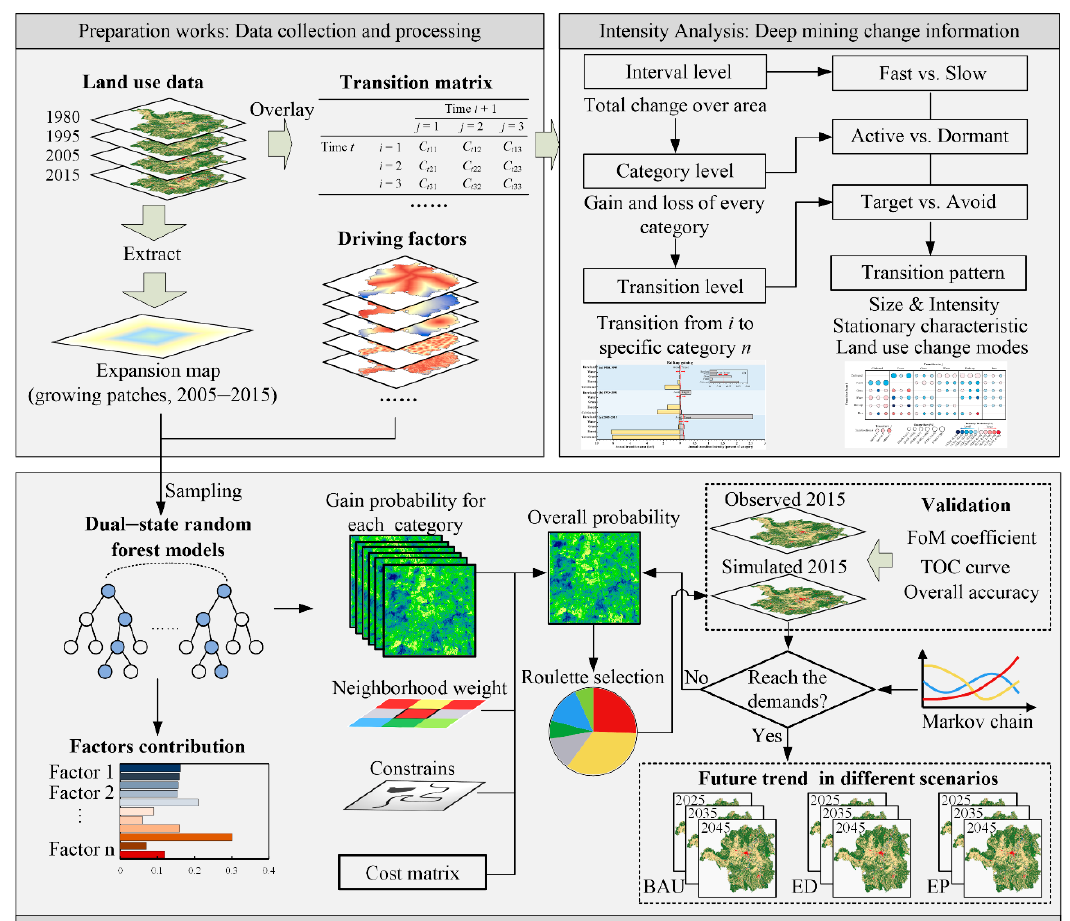
Figure 3. Research framework. PLUS: patch-generating land use simulation; BAU: business as usual scenario; ED: economic development scenario; EP: ecological protection scenario.